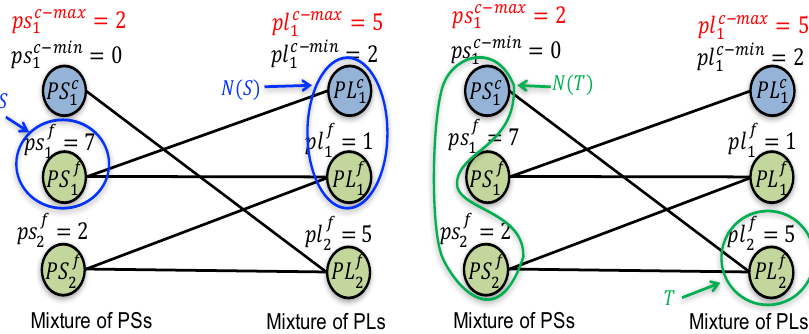
Figure 13. Demonstration example for non-feasible solution case.